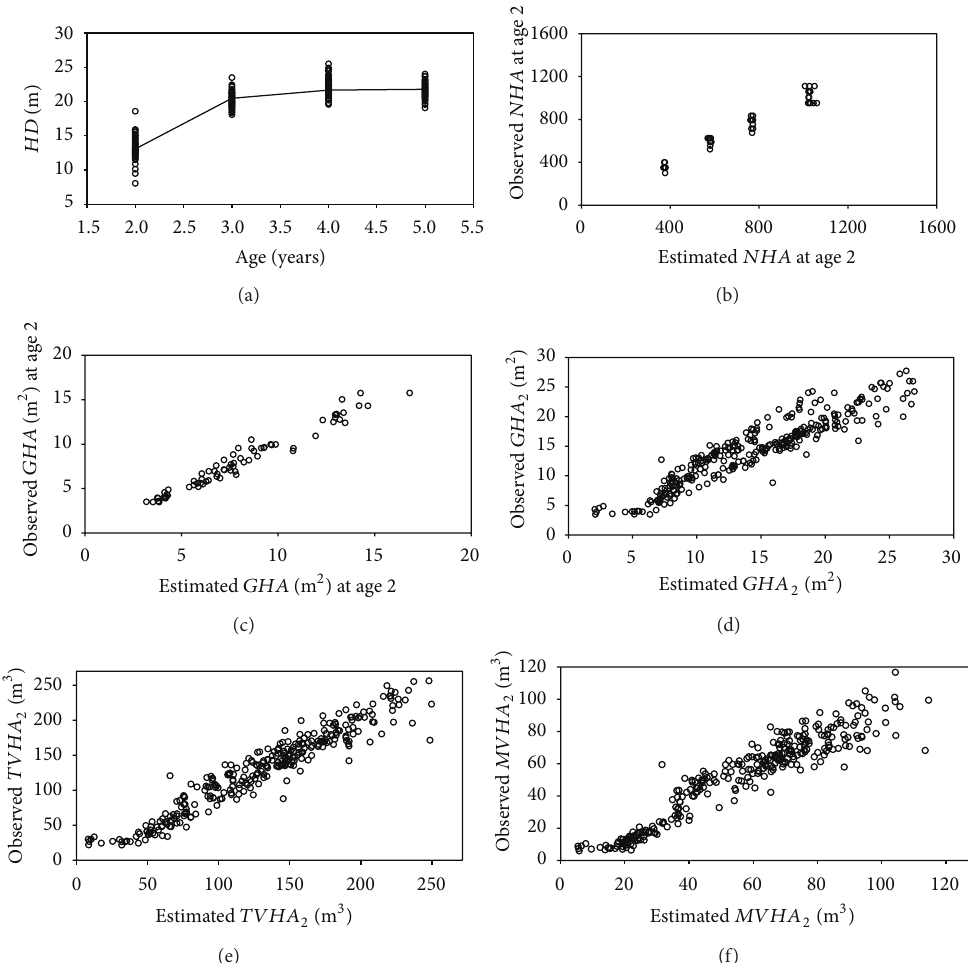
Figure 1: Graphical analysis of residues of Strategy A according to the models presented in Table 2.